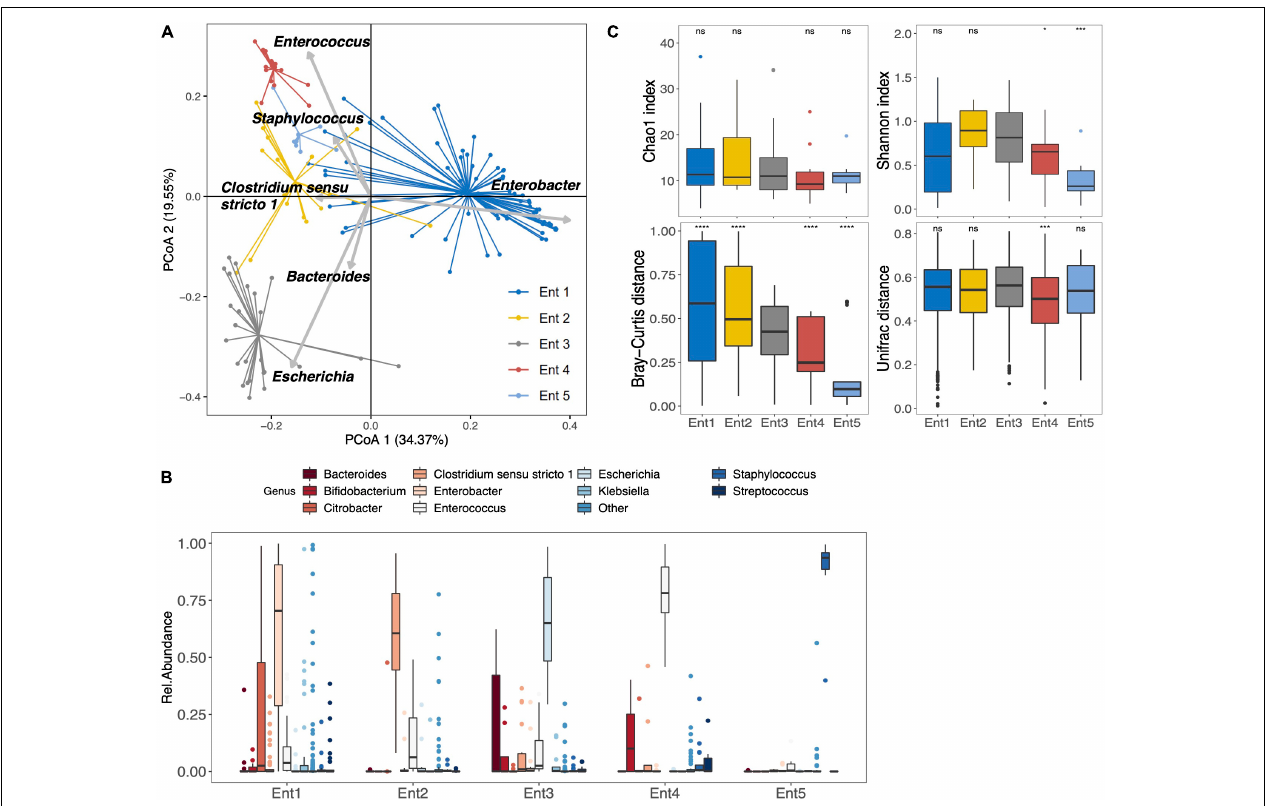
FIGURE 1 | Gut microbiota composition and diversity of the 141 preterm infants at 1 month after birth. (A) Clustering based on the genus taxonomic profiles. Biplot arrows indicate the top six genera that drive the sample to different locations on the plot. (B) The boxplots represent the relative abundance of the top 10 genera distributed among the five enterotypes. The sixth enterotype is not represented because it is constituted by infants without sample amplification (low bacterial load). The boxplots show the smallest and largest values, 25 and 75% quartiles, the median, and outliers. (C) Boxplots of alpha diversity (top) assessed by Chao1 and Shannon index, and pairwise beta diversity dissimilarities (bottom) assessed by Bray–Curtis and Unifrac distances within enterotypes based on genus taxonomic profiles (* p < 0.05, **** p < 0.001, ns = p > 0.05, Reference group = Ent3); Ent,